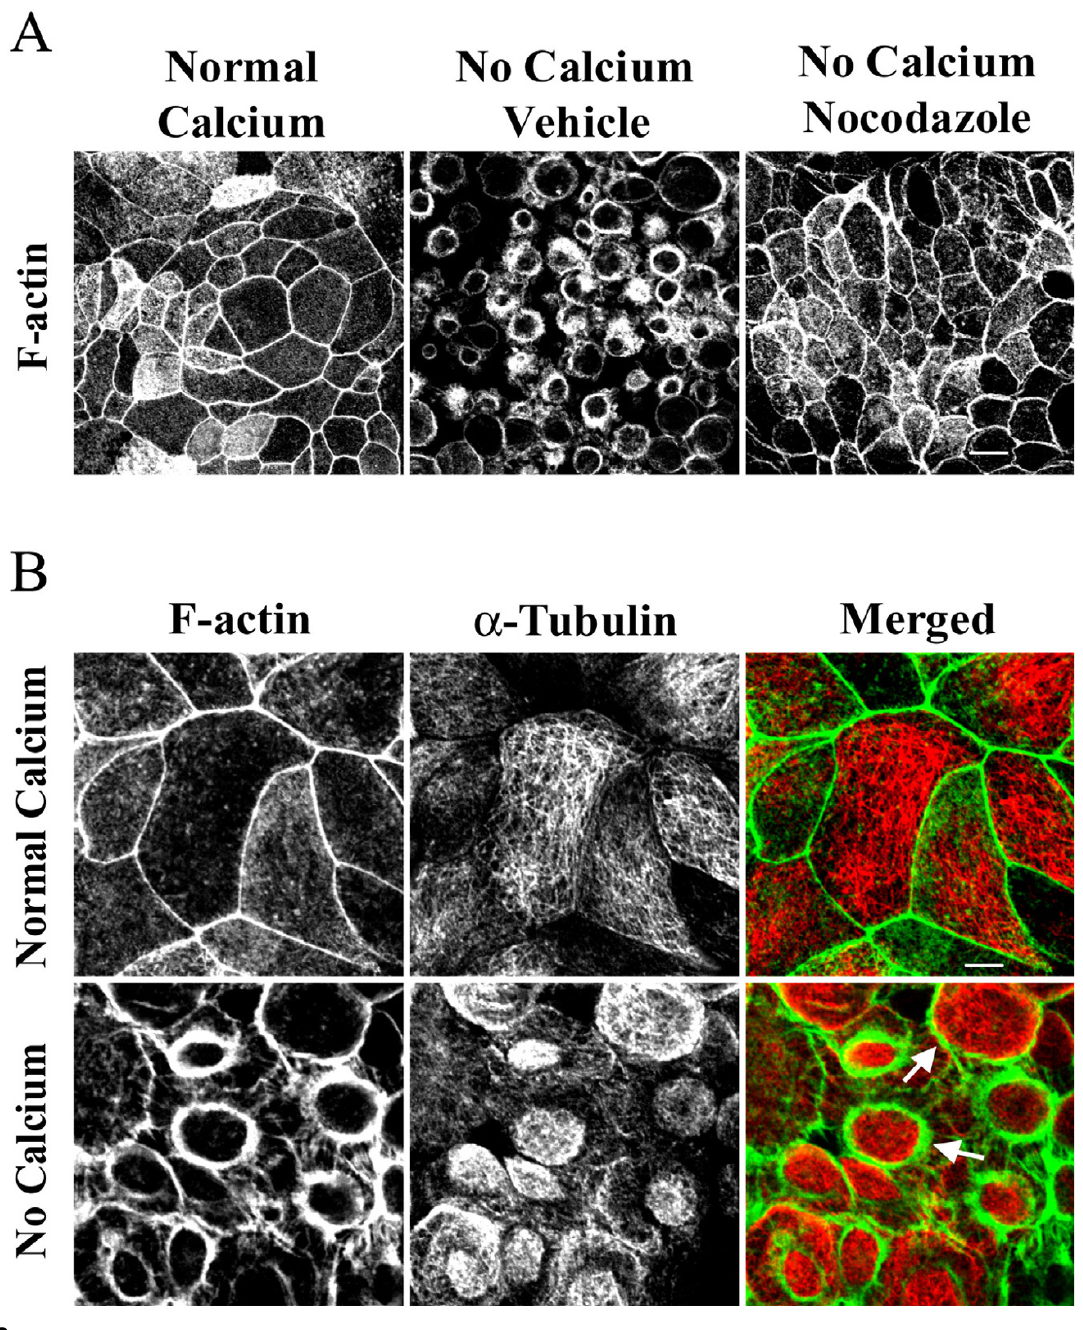
Figure 3 Microtubules regulate formation of contractile F-actin rings in calcium-depleted epithelial cells. (A) In confluent SK-CO-15 cells cultured in the normal-calcium medium, apical actin is organized in a perijunctional F-actin belt at the AJC level. In vehicle treated cells, calcium depletion for 1 h resulted in formation of apical contractile F-actin rings, whereas depolymeri- zation of microtubules with nocodazole (30 µ M) prevents assembly of F-actin rings. Bar, 10 µ m. (B) In SK-CO-15 cells cultured at normal-calcium conditions, apical microtubules (red color) are organized in a loose horizontal meshwork, which does not significantly overlap with F-actin (green color). Calcium depletion results in reorganization of microtubules into dense plaques positioned inside contractile F-actin rings where microtubules partially colocalize with actin microfilaments (arrows). Bar, 5 µ